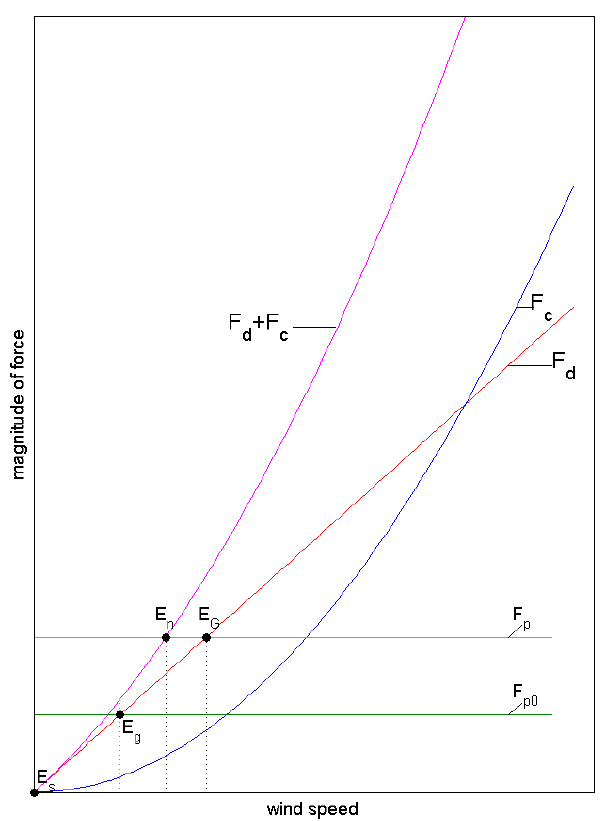
Figure 5. A diagram of the evolution of the anomalous